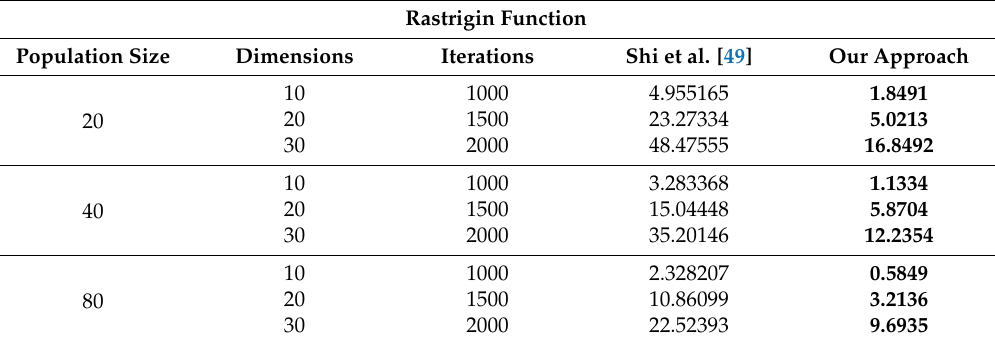
Table 17. Comparison against Shi et al.